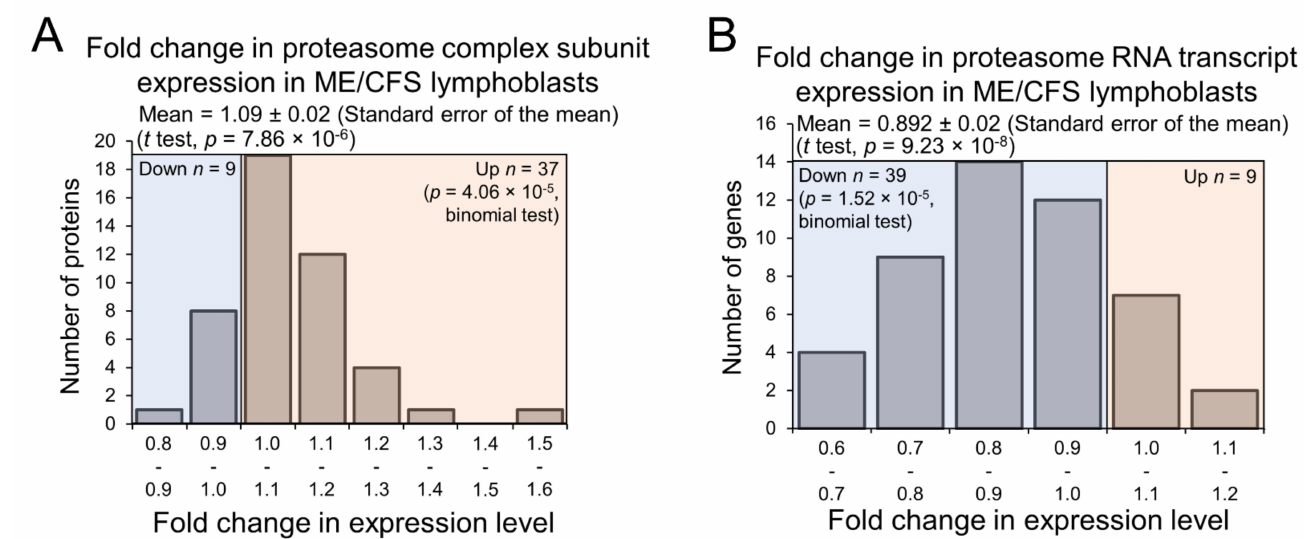
Figure 8. Expression of proteasome complexes in Myalgic Encephalomyelitis/Chronic Fatigue Syndrome (ME/CFS) lymphoblasts is upregulated at the protein level but downregulated at the transcript level. Error bars represent the standard error of the mean. RNA sequencing transcriptomics experiment: ME/CFS n = 23, control n = 17. Each cell line was sampled once. Mass spectrometry proteomics experiment: ME/CFS n = 34, control n = 31. Each cell line was sampled once, or twice for a subset of healthy controls arbitrarily selected to act an internal control between experiments in the mass spectrometry proteomics work. ( A ) A total of 46 proteasome complex subunits were detected within the whole-cell proteomes of ME/CFS and control lymphoblasts. Fold change refers to the mean abundance of a given protein in the CFS group divided by the mean abundance in the control group. The fraction of detected proteins that were upregulated (binomial test with H o set to 0.5) and the average extent of the upregulation (single-sample t test with H o m = 1) were statistically significant. ( B ) A total of 48 RNA transcripts encoding proteasome complex subunits were detected within the whole-cell transcriptomes of ME/CFS and control lymphoblasts. Fold change refers to the mean abundance of a given transcript in the CFS group divided by the mean abundance in the control group. The fraction of detected transcripts that were downregulated (binomial test with H o set to 0.5) and the average extent of the downregulation (single-sample t test with H o m = 1) were statistically